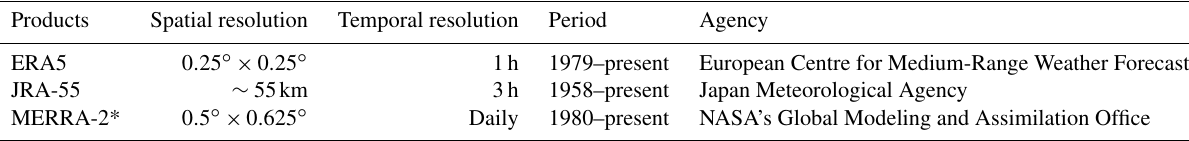
Table 2. Information on the three reanalysis products.